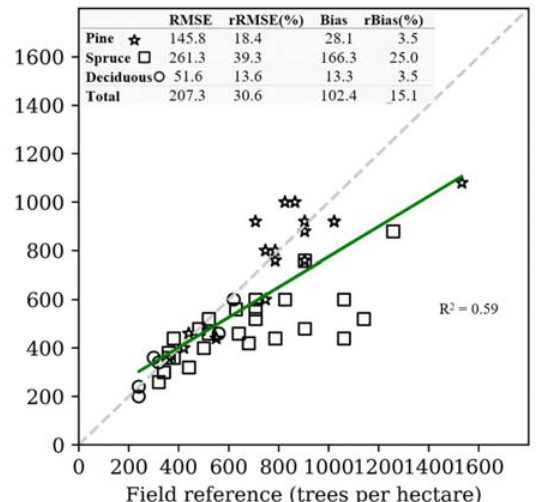
underestimation (rRMSE: 13.6%).